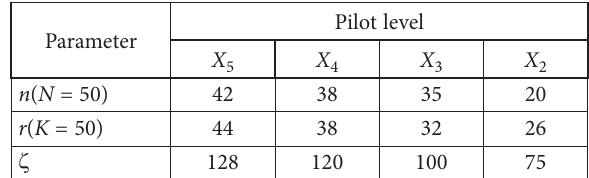
Table 2. Minimum numbers of occurrences that pilots can competently handle sorted by their level